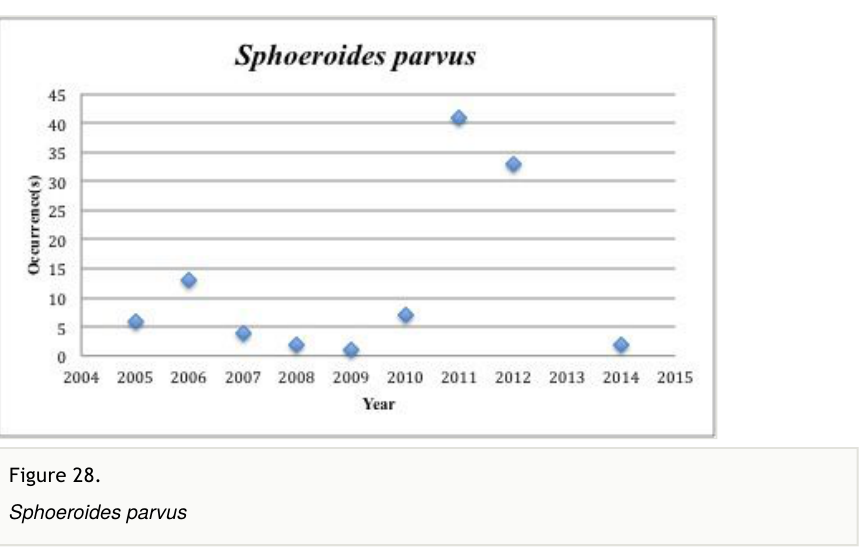
Figure 28. Sphoeroides parvus